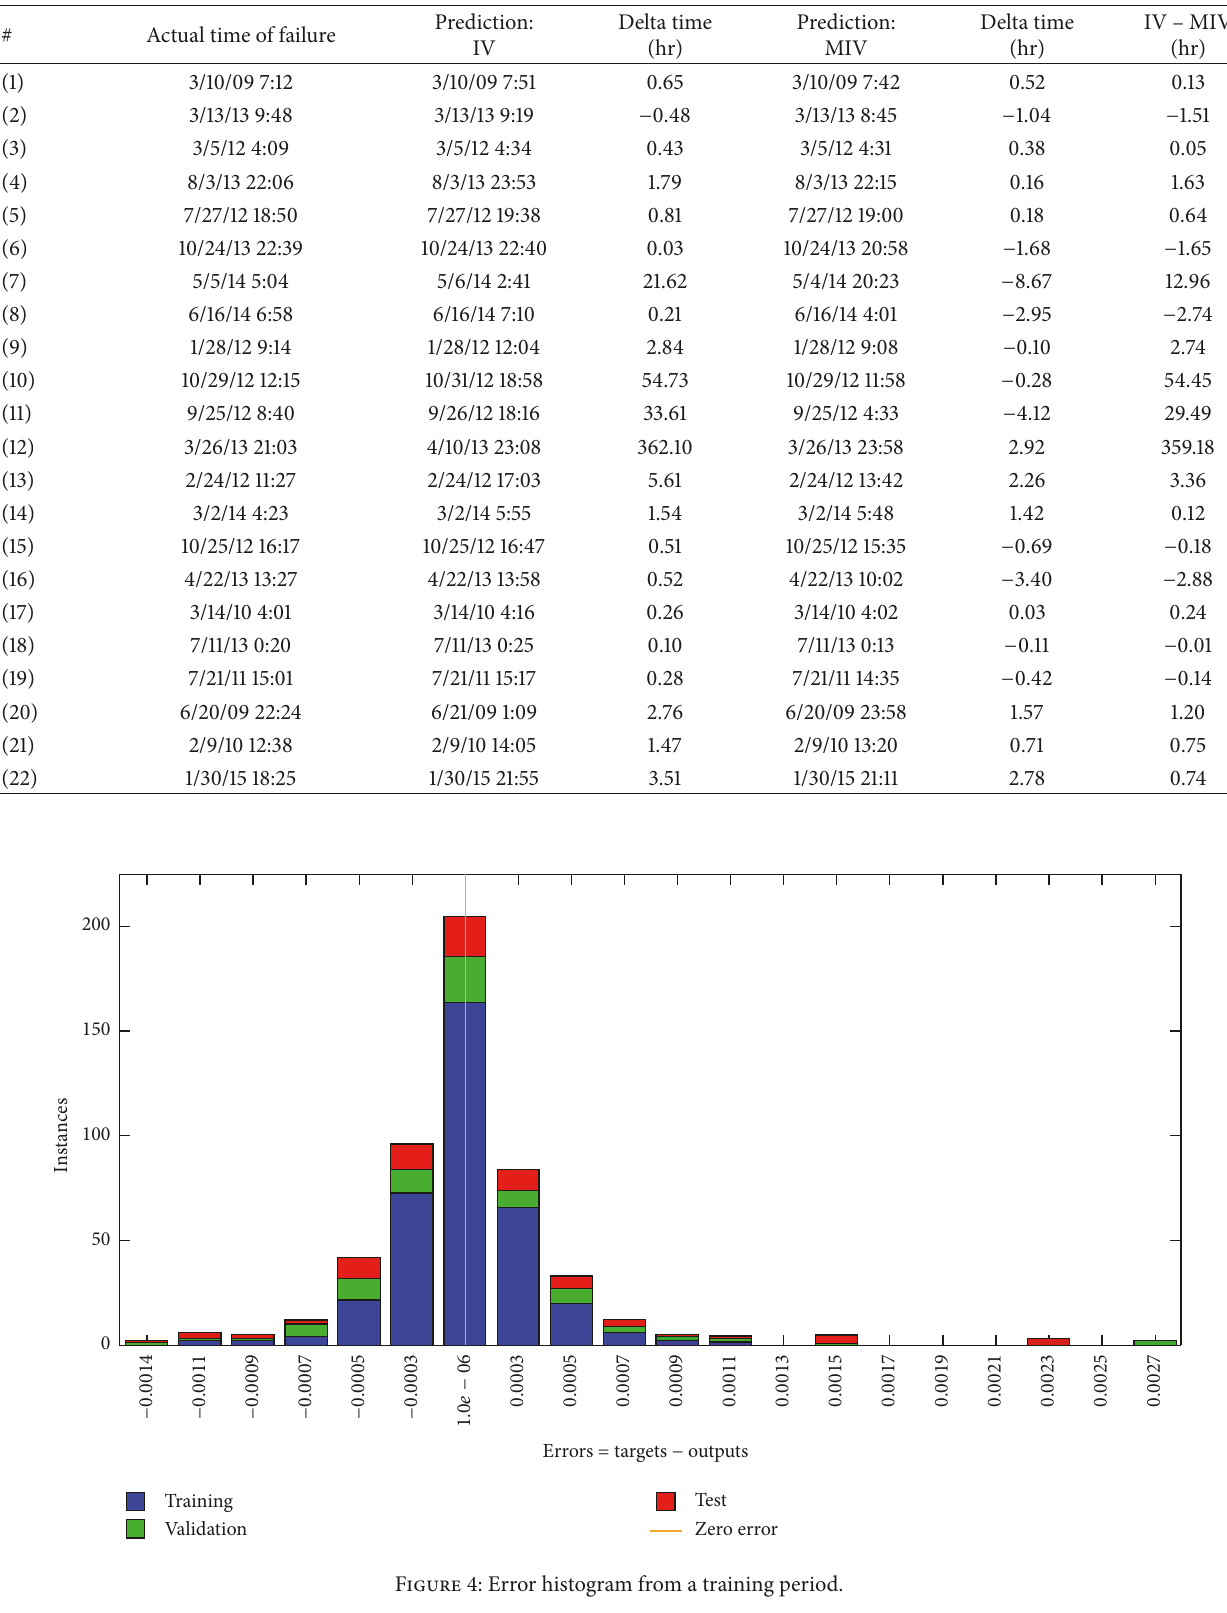
Table 1: Results of the comparison between inverse velocity (IV) method and minimum inverse velocity (MIV) method from 22 different failure examples. For the analysis demonstrated below, all calculations are based on a 60-minute averaging window.